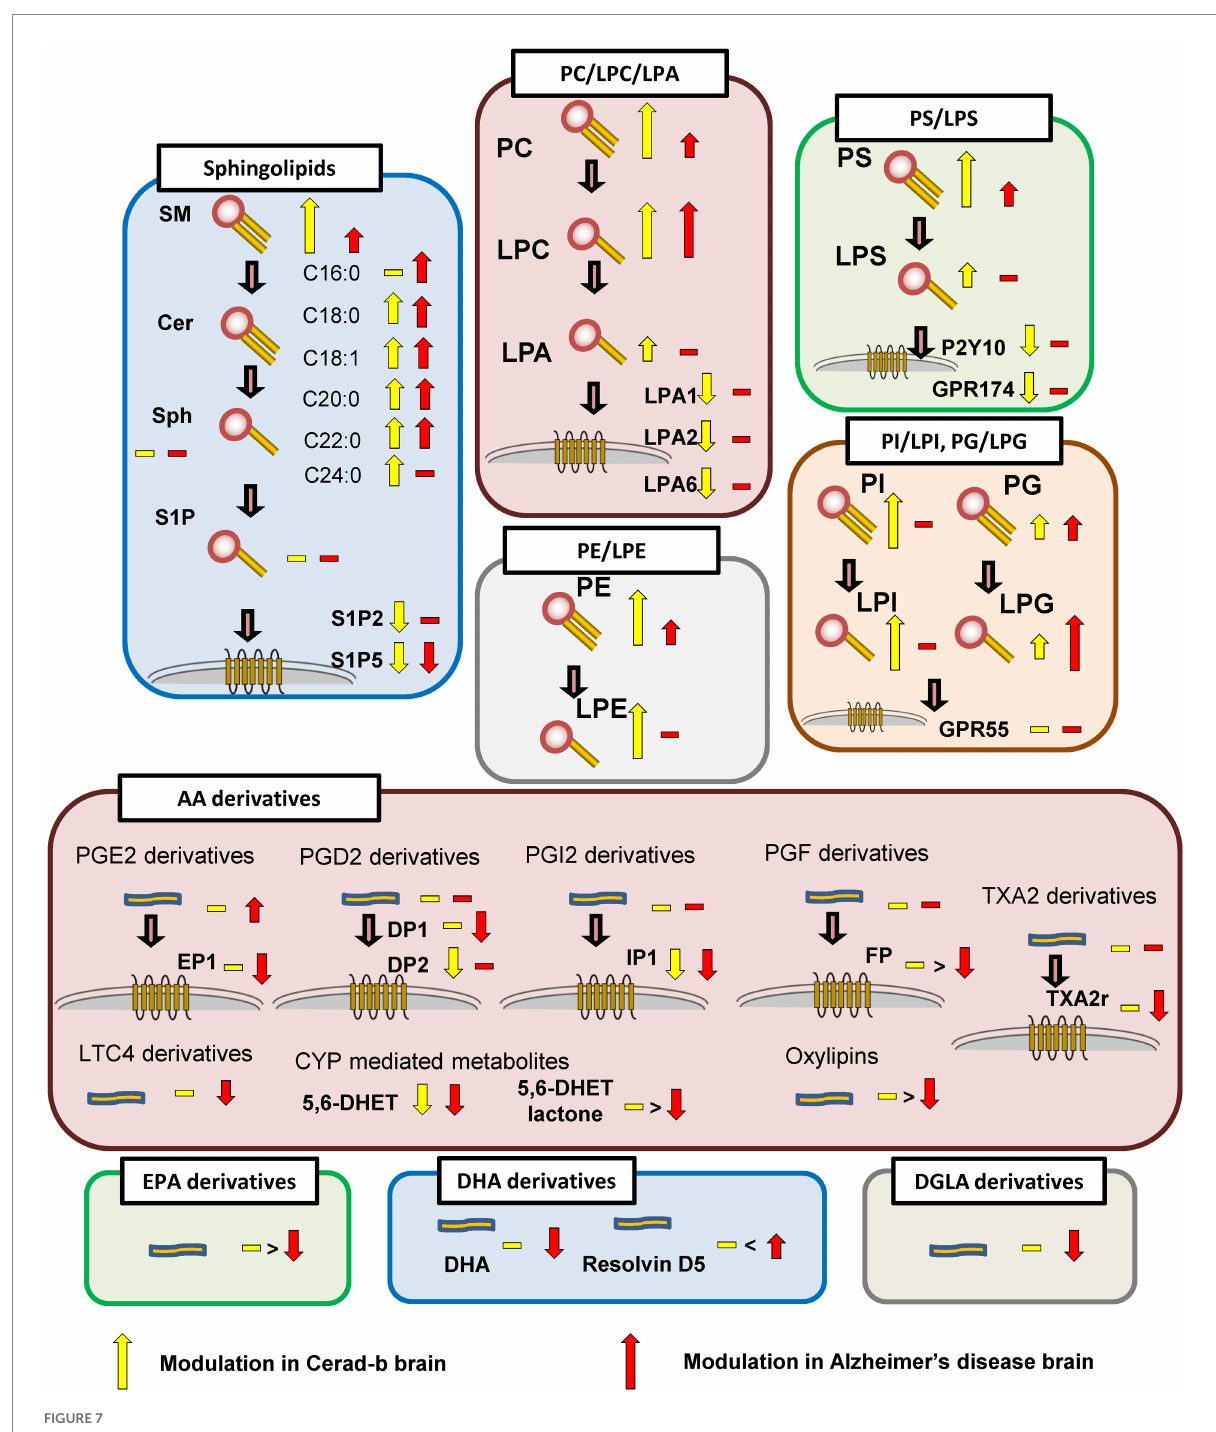
FIGURE 7 Schematic showing modulation of bioactive lipid species in the brain in